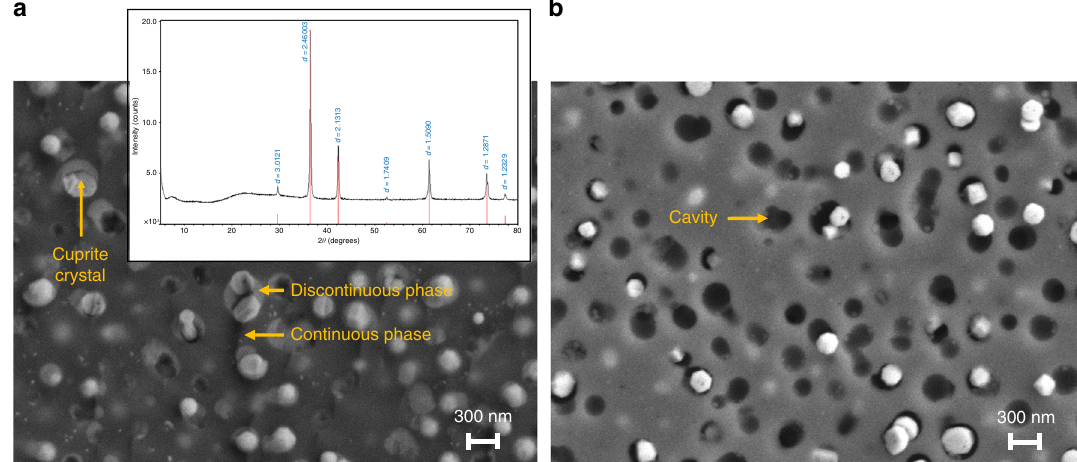
Fig. 2 Scanning electron microscope (SEM) images of copper – glass ceramic cross-section before and after exposure to water a Cross-section of the copper – glass ceramic shown prior to water exposure reveals a continuous glassy phase, a discontinuous glassy phase, and a cuprite crystalline phase trapped in the discontinuous phase. Inset is X-ray diffraction (XRD) data collected on copper – glass ceramic powder which shows that the crystalline species present is cuprite. b Cross-section of the copper – glass ceramic shows the formation of cavities following water exposure (~120 min) due to dissolution of the discontinuous glassy phase that lead to the release of cuprite crystals into solution